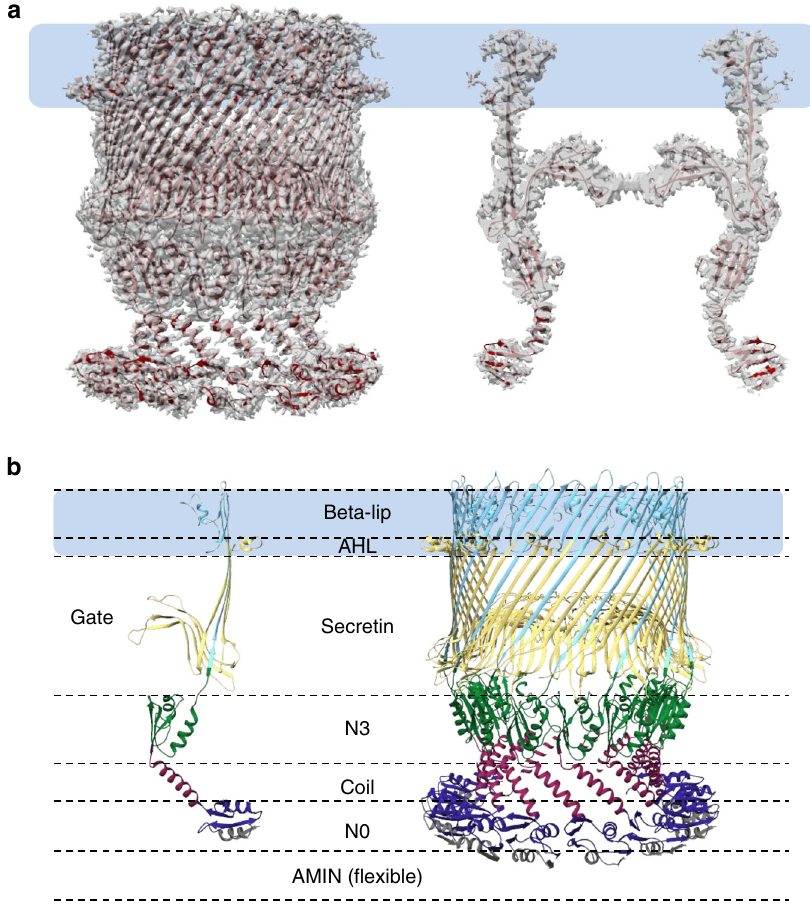
Fig. 1 CryoEM structure of the V. cholerae type IV competence pilus secretin PilQ. a Model (cartoon in dark red) and cryoEM density (dark gray transparent) of symmetrized Vibrio cholerae PilQ (VcPilQ) is shown from the side (left) and cut through the center (right). The putative outer membrane region is represented in a light blue rectangle. b The atomic model of the VcPilQ multimer is shown (right). One chain is shown by itself (left). The putative outer membrane region is represented in a light blue rectangle. Dashed lines represent the different domains of the VcPilQ structure: AMIN (not shown), N0 (gray/dark blue), coil (purple), N3 (green), secretin (yellow), beta lip (sky blue). The gate region is labeled on the